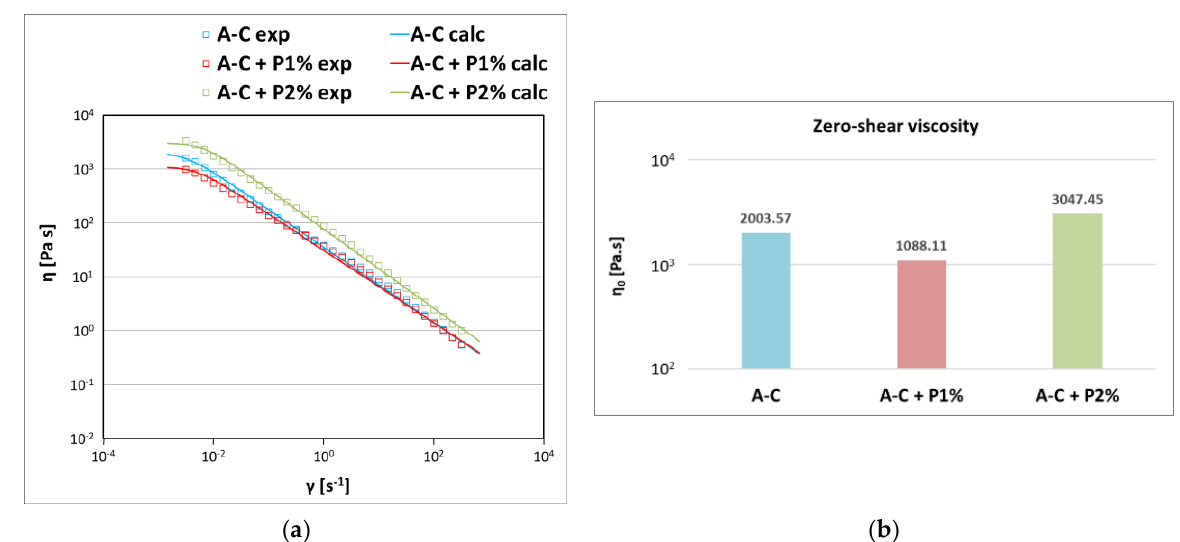
Figure 10. Viscosity trend as a function of the shear rate ( a ) with flow curves (exp) fitted with the Carreau − Yasuda